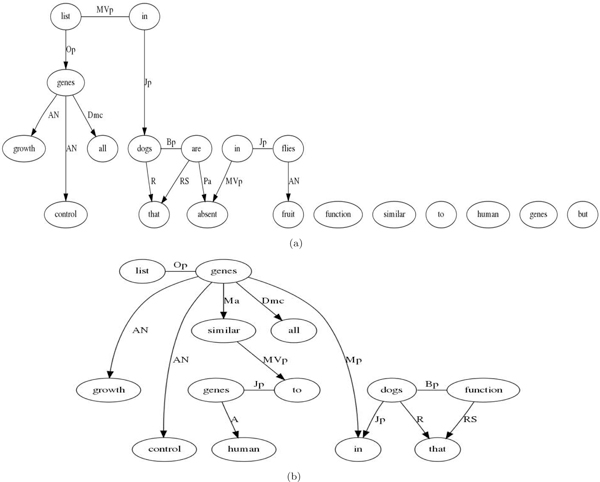
Query parse trees.